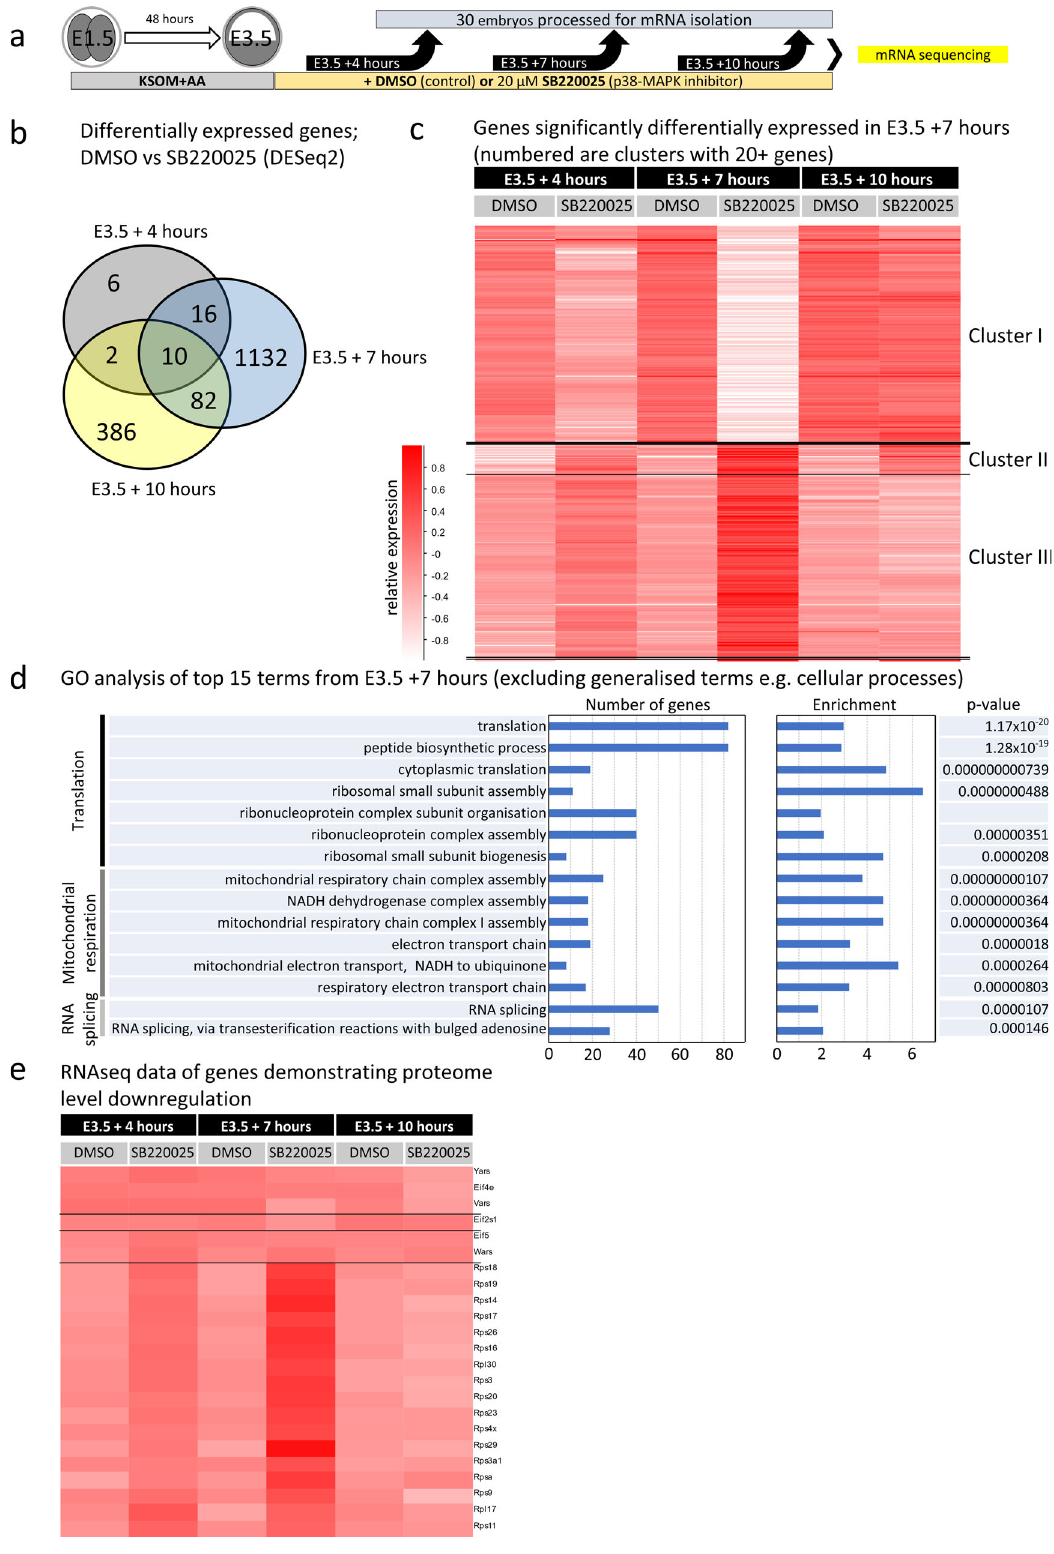
returned to levels equivalent to the control levels by E3.5 + 10 h. The transcripts in cluster III demonstrated a similar but inverted trend. Namely, at E3.5 + 4 h, p38-MAPKi initiated an increase in transcript expression that peaked by E3.5 + 7 h, but the expression returned to control levels by E3.5 + 10 h. Cluster II comprised similarly enhanced transcripts but was